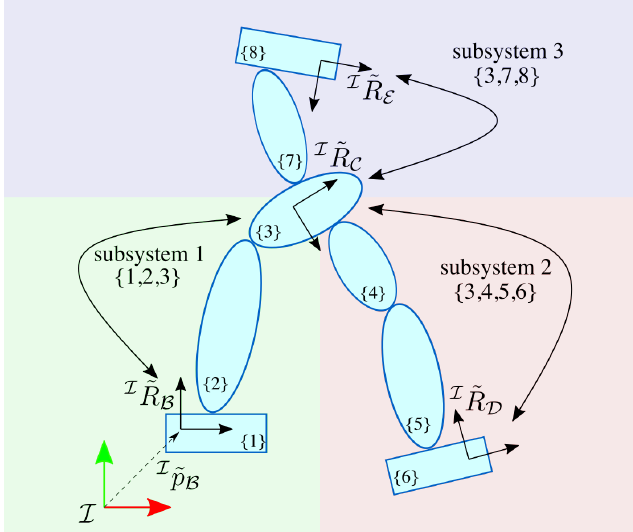
Figure 6. A floating base model with eight links and four orientation targets ( I R B , I R C , I R D , I R E ) can be divided into three subsystems, with a pair of orientation targets each, in order to solve the inverse kinematics problem as pair-wised instantaneous